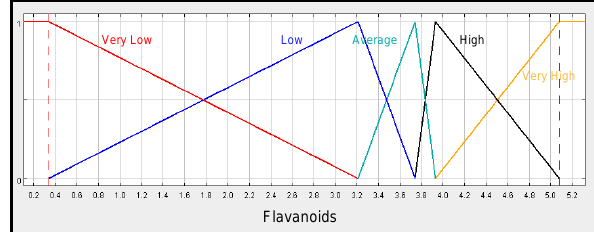
Figure 3: Linguistic terms and membership functions of variable Flavanoids